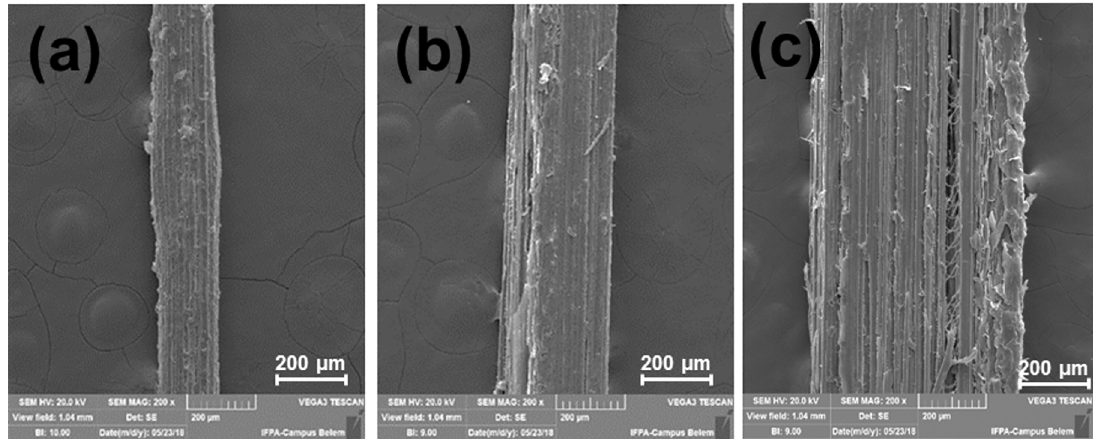
Figure 4. SEM micrographs of typical guaruman fibers (a) thin; (b) medium; and (c) thick diameter.